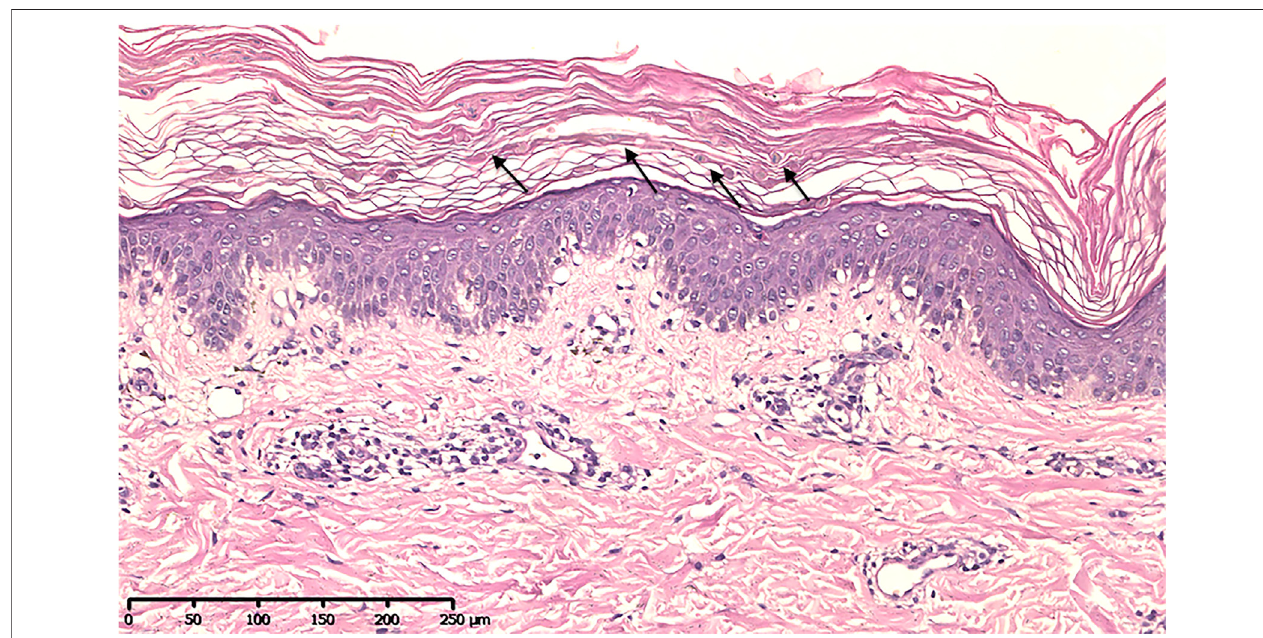
FIGURE3| Histopathologicalimageshowingmanygraincellswithdyskeratosisinthegranularlayer,acanthosis,papillomatosis,andamildsuper fi cialperivascular lymphocytic in fi ltrate (H&E).